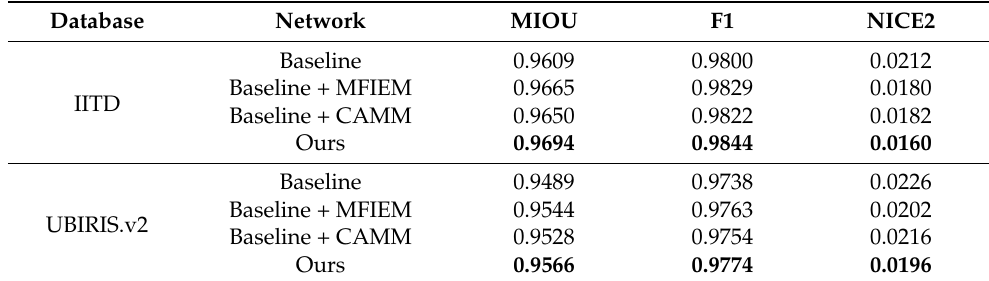
Table 4. Network ablation experiments.